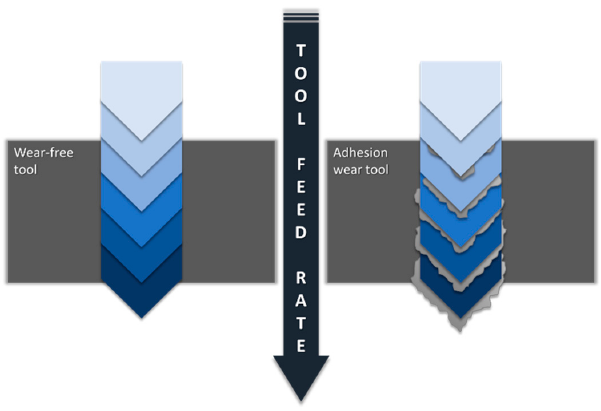
Figure 2. Influence of adhesive wear on the surface, dimensional and geometric quality of the borehole.